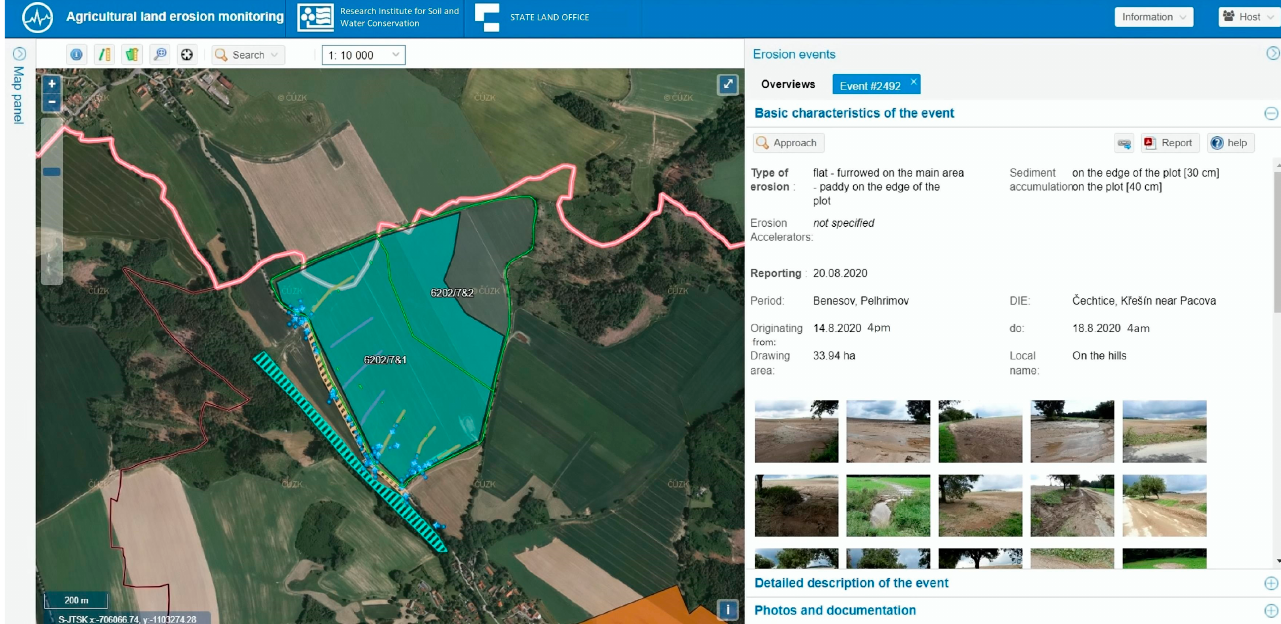
Figure 3. An example of a recorded soil erosion event in the monitoring database (MoE).